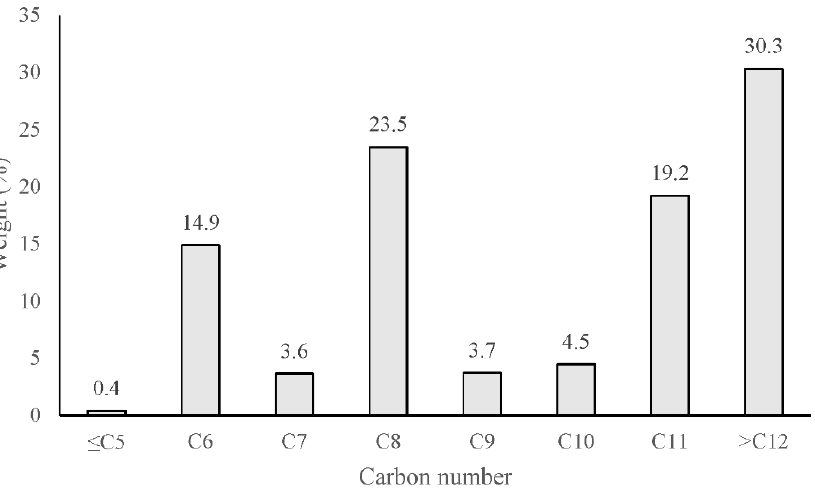
Environments 2022 , 9 , x FOR PEER REVIEW Figure 10. Hydrocarbon composition (by number of carbons) of non-isothermal pyrolysis condensate. Figure 10. Hydrocarbon composition (by number of carbons) of non-isothermal pyrolysis conden- Figure 10. Hydrocarbon composition (by number of carbons) of non-isothermal pyrolysis conden- sate. sate.